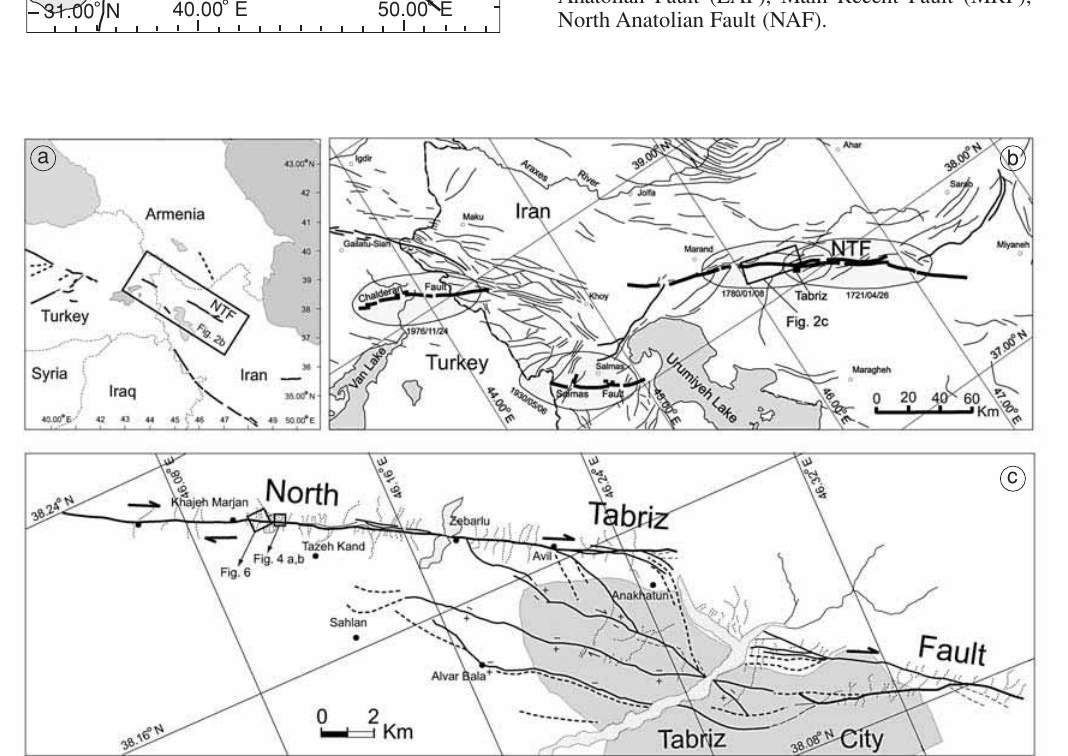
Fig. 1. Location map of the NW Iran-Eastern Turkey, adapted from Jackson (1992), with focal mecha- nisms of some of the large earthquakes ( m b > 5.3) in the Tabriz-Chaldiran seismogenic zone (Jackson and McKenzie, 1984). North Tabriz Fault (NTF), East Anatolian Fault (EAF), Main Recent Fault (MRF), North Anatolian Fault